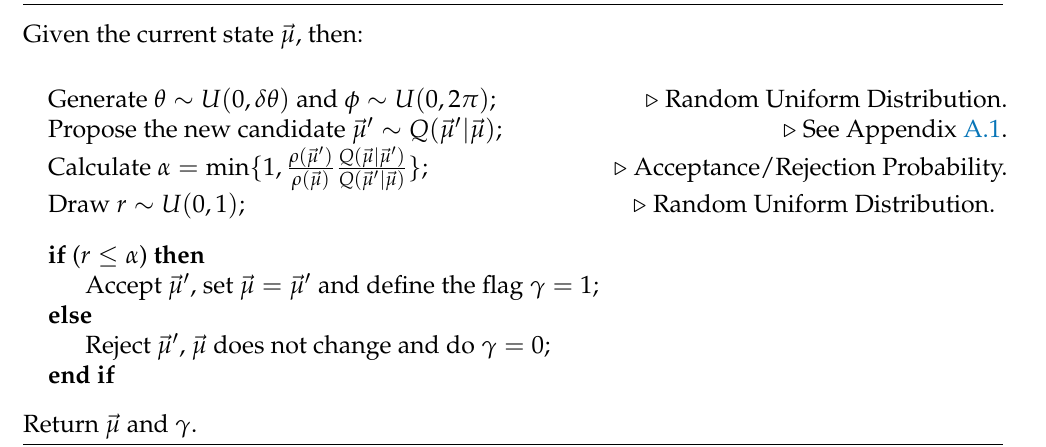
Algorithm 1 Metropolis–Hastings Algorithm.